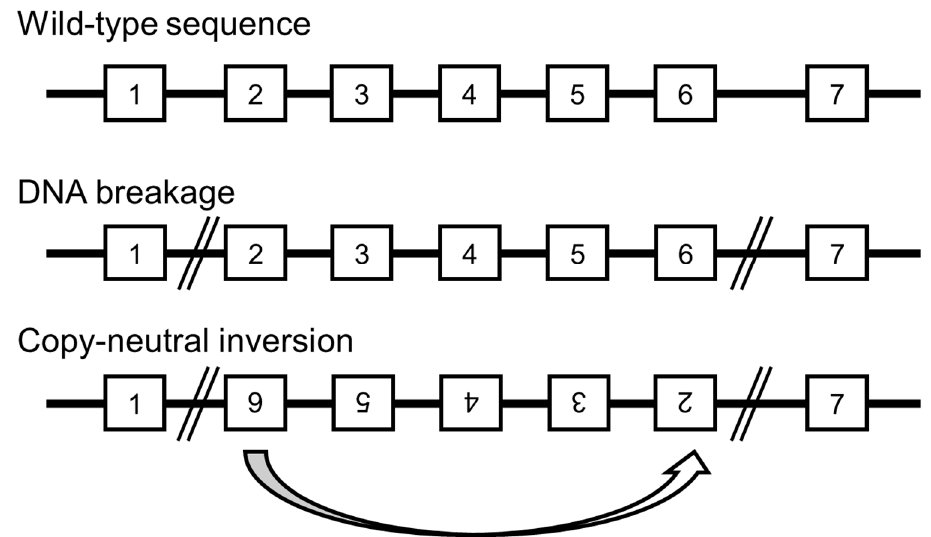
Figure 4. Possible mechanism of copy-neutral inversion that cannot be detected by chromosomal microarray testing and exome sequencing.